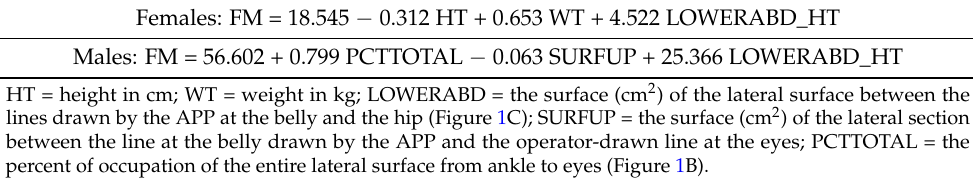
Table 2. Multiple regression equations to predict body fat mass (FM) of 117 healthy